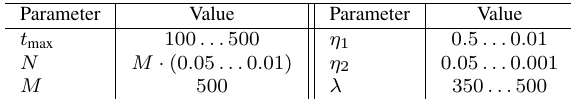
with the increasing amount of data.